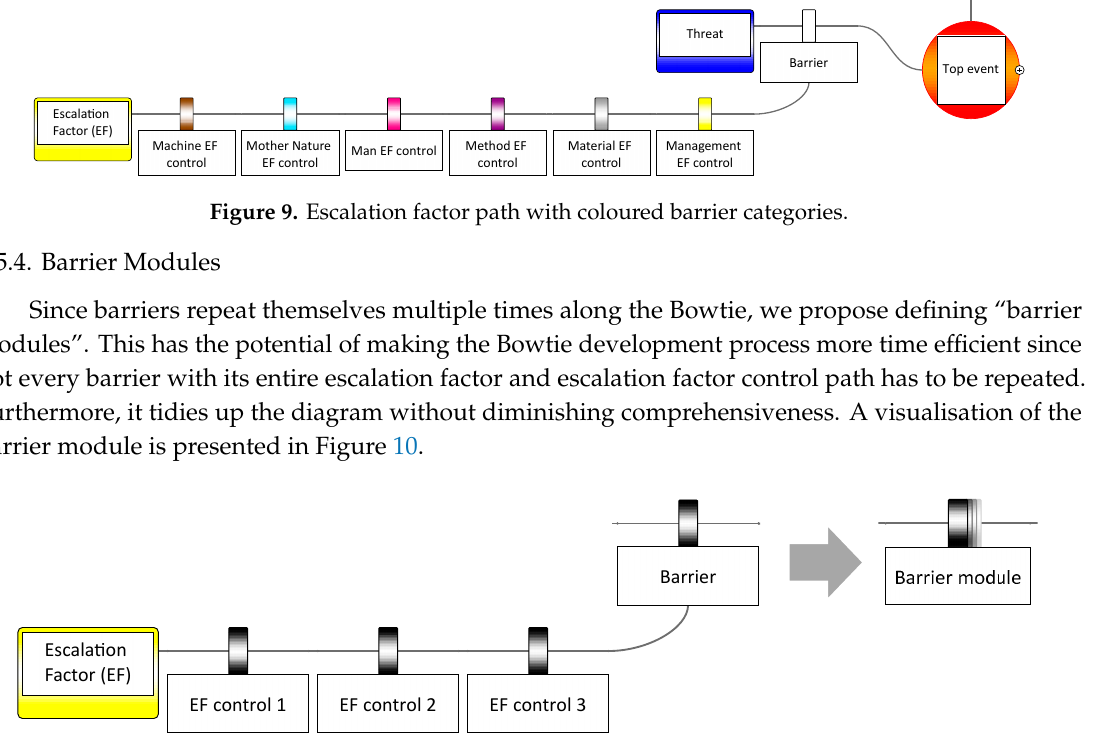
Figure 10. Potential visualisation of barrier modules encapsulating escalation factors and its controls.